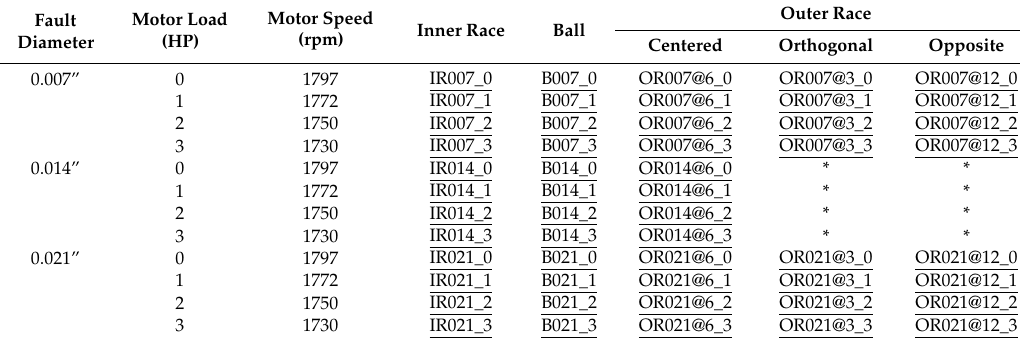
Table 3. CWR test datasets (collected data at 48,000 samples / second) [45]. * data is not available in the